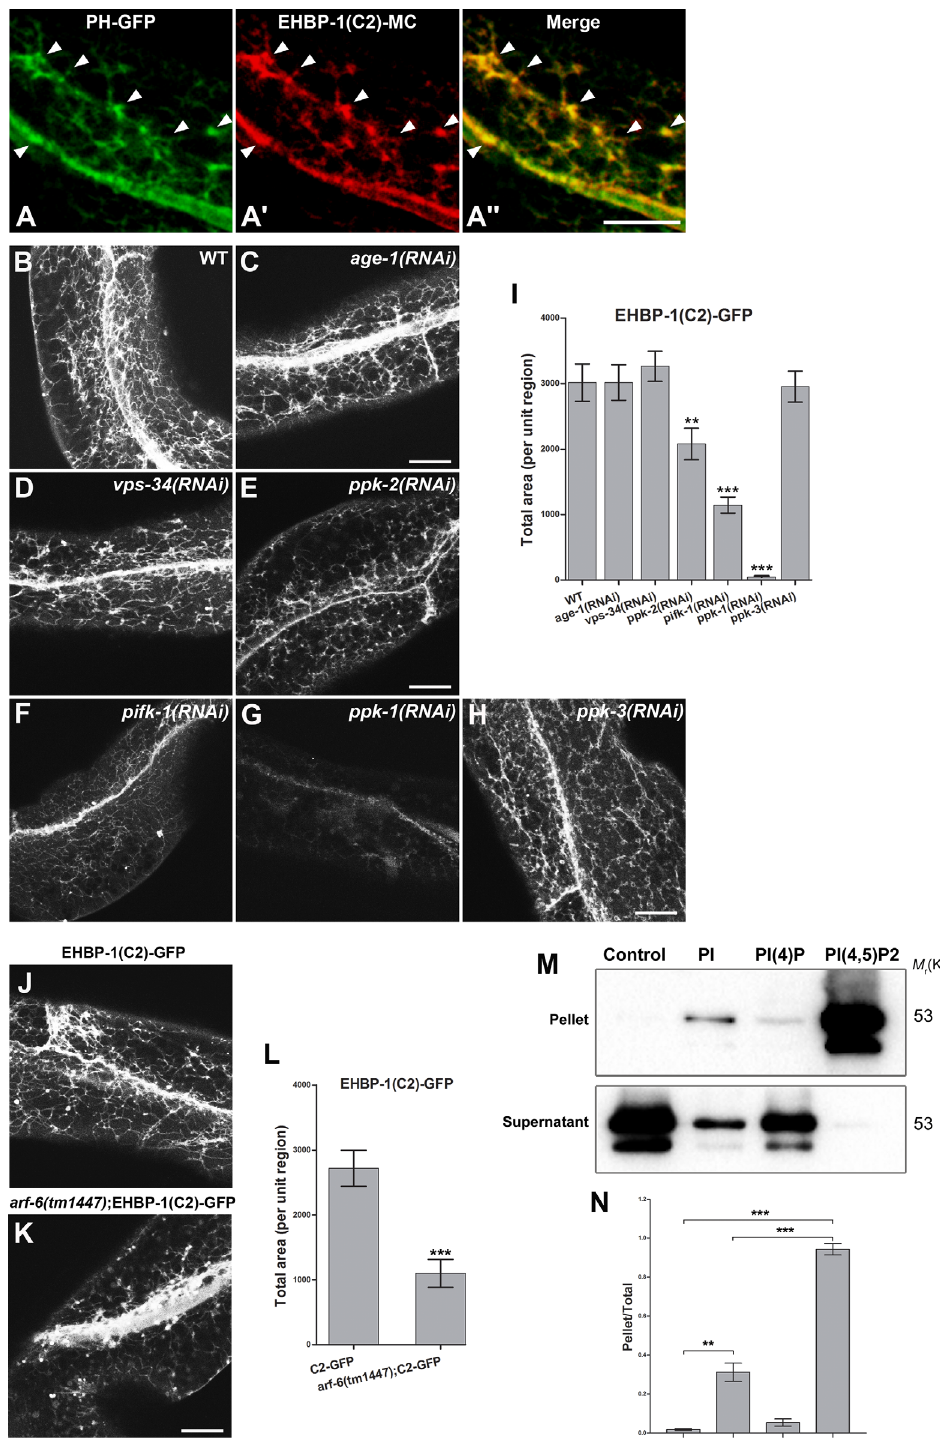
Fig 3. The EHBP-1 NT-C2 domain requires PI(4,5)P2 for localization to endosomal structures. (A-A") EHBP-1(NT-C2 domain)-mCherry colocalizes with PH(PLC δ )-GFP (PI(4,5)P2 biosensor) on tubular and punctate endosomes. Representative images from confocal image stacks are shown. All images were acquired in intact living animals expressing GFP and mCherry tagged proteins specifically in intestinal epithelial cells. Arrowheads indicate structures labeled by both PH-GFP and EHBP-1(NT-C2)-mCherry.